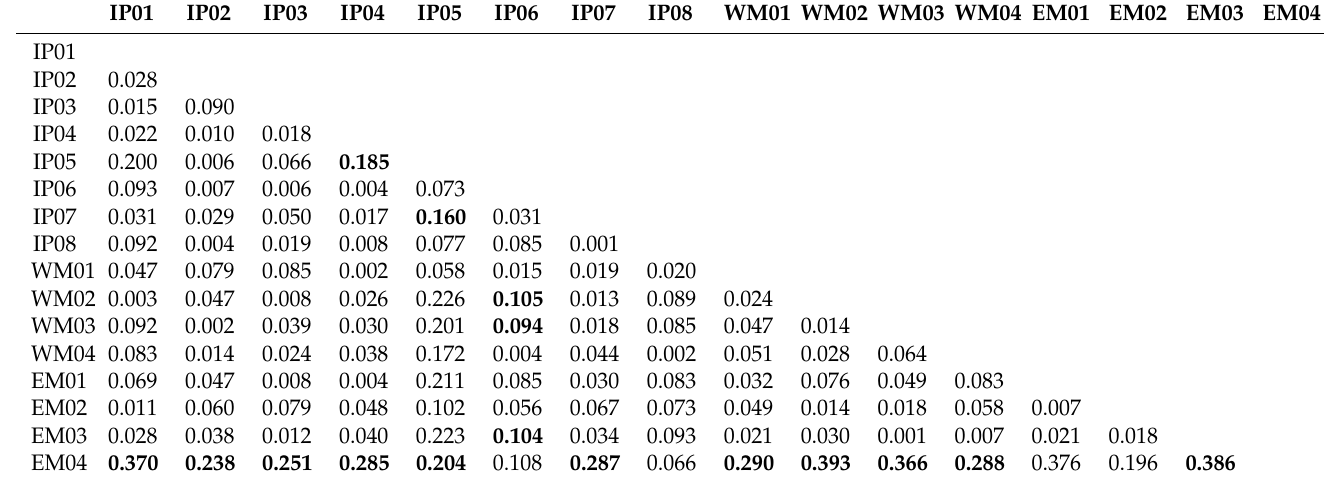
Values in bold are significantly different from zero after sequential Bonferroni correction. Table 4. Pairwise F ST values among the 11 populations of Hedyotis chrysotricha in the Zhoushan Archipelago (ZA)